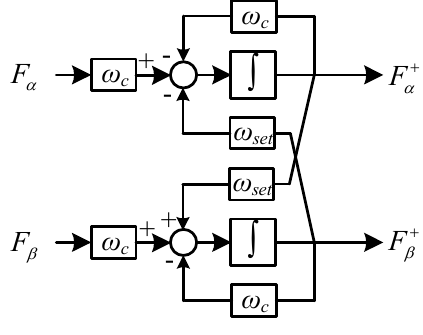
Figure 5. The implementation diagram for positive sequence separation.